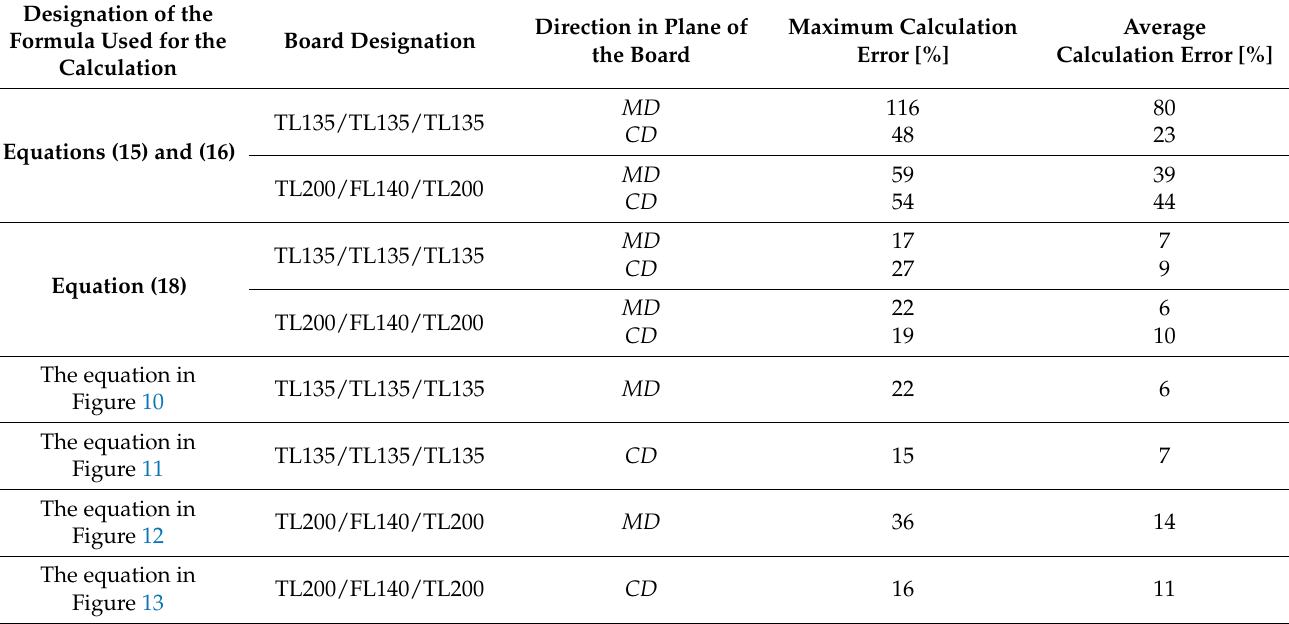
Table 6. Calculation errors, BS